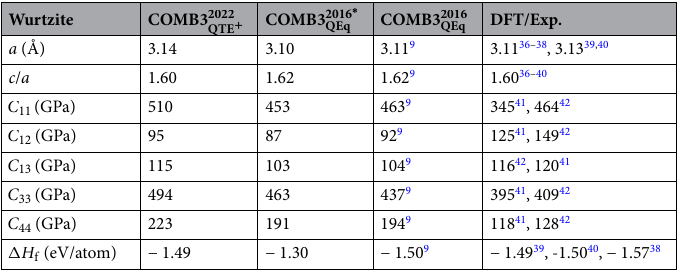
Table 2. Wurtzite AlN properties obtained with COMB3 2022 COMB3 2016 QEq AlN publication, and DFT as well as experimental findings.